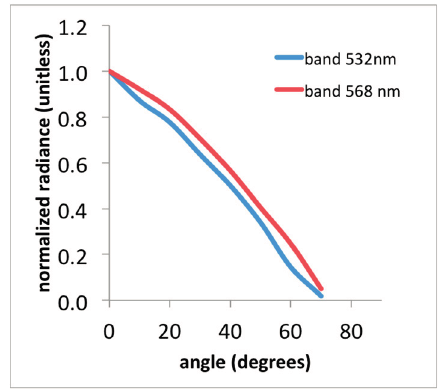
Figure 4. Results from goniometer measurements show waveband response across a range of incidence angles. Note the sensor field of view is approximately 140°.